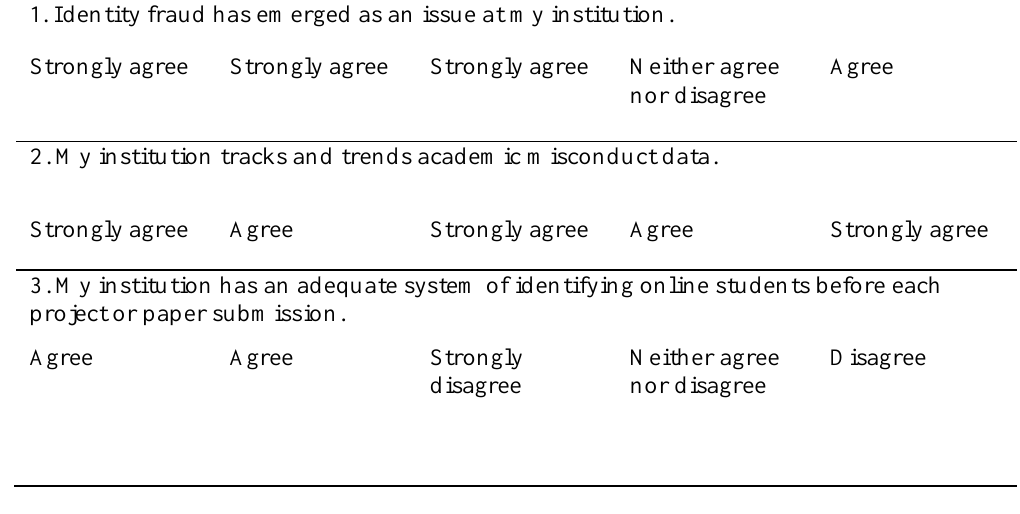
Likert-Like Scale Survey Responses Case